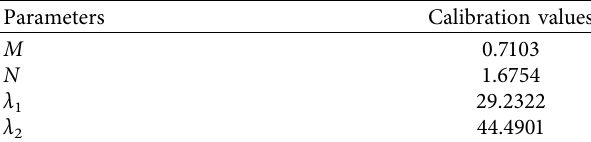
Table 1: Result of parameter calibration of